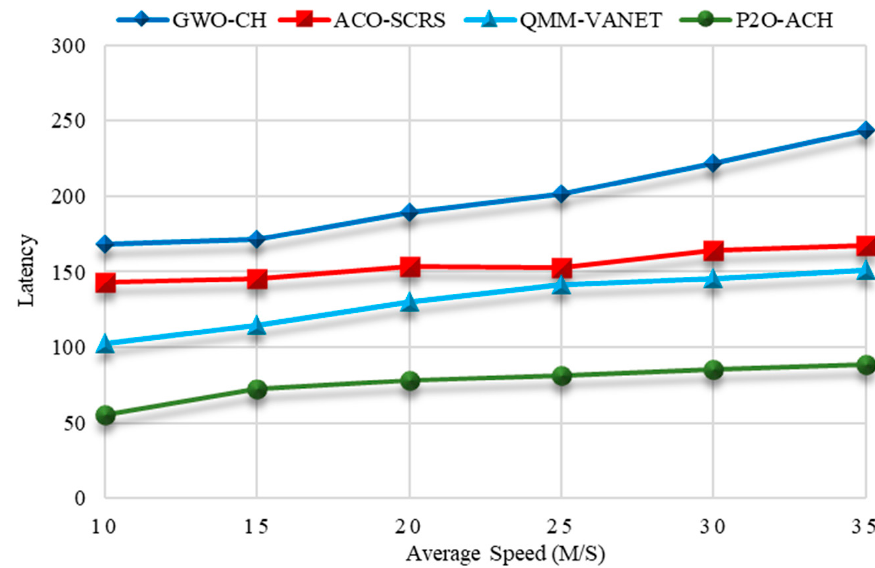
Figure 15. Latency Calculation.